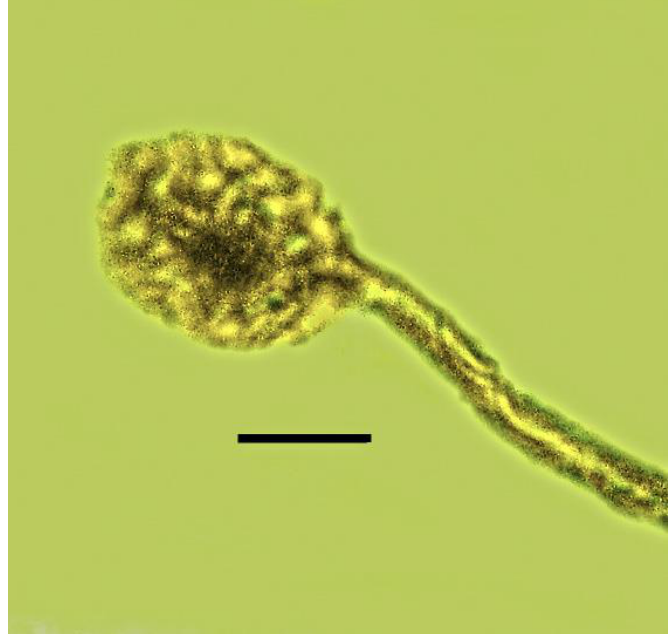
Figure 23. Conidiophore of the ambrosia fungus, Paleoambrosia entomophila (Ophiostomatales: Ophiostomataceae) on Palaeotylus femoralis (Coleoptera: Curculionidae: Platypodinae) in Burmese amber. Scale bar = 6 µm.